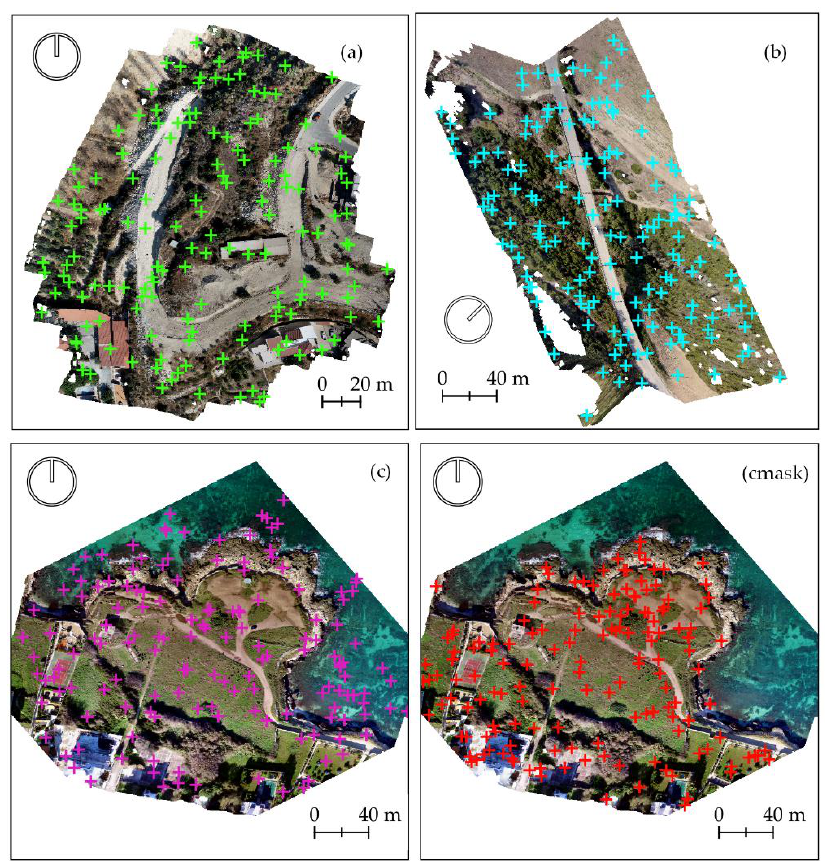
Figure 5. Distribution of random points analysed for examining the yields of vegetation indices in scenarios (a), (b) and (c). The distribution for scenario ( c ) subjected to the masking operation of the water zones, called (c mask ), was also represented.